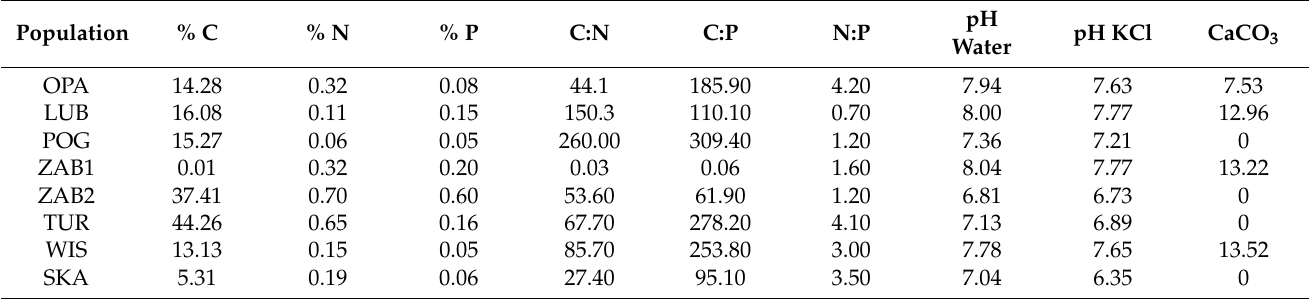
Table 2. Soil parameters for Neottia ovata